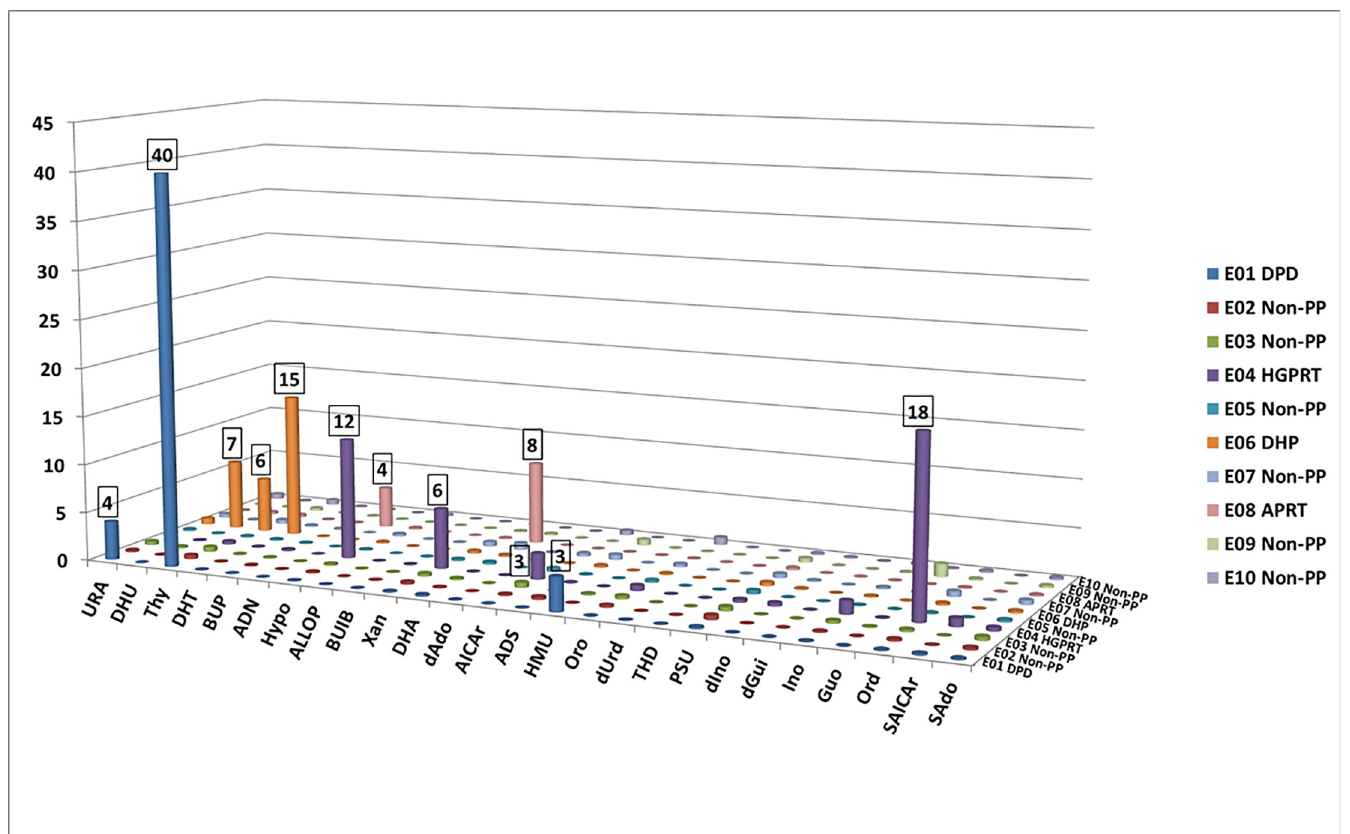
Fig 1. Results of the ERNDIM Diagnostic Proficiency Testing (DPT) samples ( n = 10). Numbers on the cylinders show how many times a given result exceeded the respective cutoff for that biomarker. PP: purine-pyrimidine disorder. Further abbreviations are provided in the List of Abbreviations Section. Note that orotidine is not pathognomonic for HGPRT (sample E04) but is accumulated as a result of allopurinol